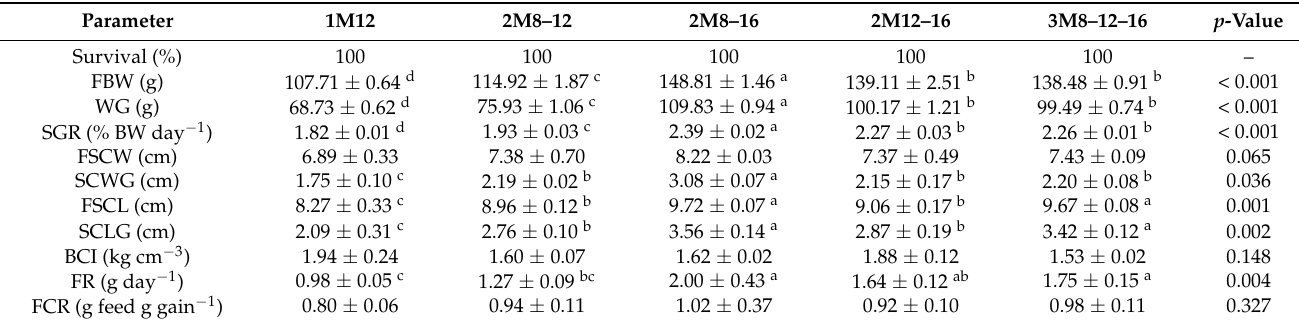
Table 1. Survival, growth performance, and feed utilization of hawksbill sea turtles fed at various frequencies. The observed parameters were recorded at the end of the 8-week experiment.